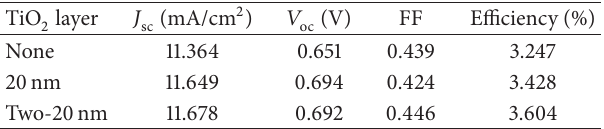
Table5:PerformanceofsimulatedDSCwithoutandwithsingleand two TiO 2 passivation